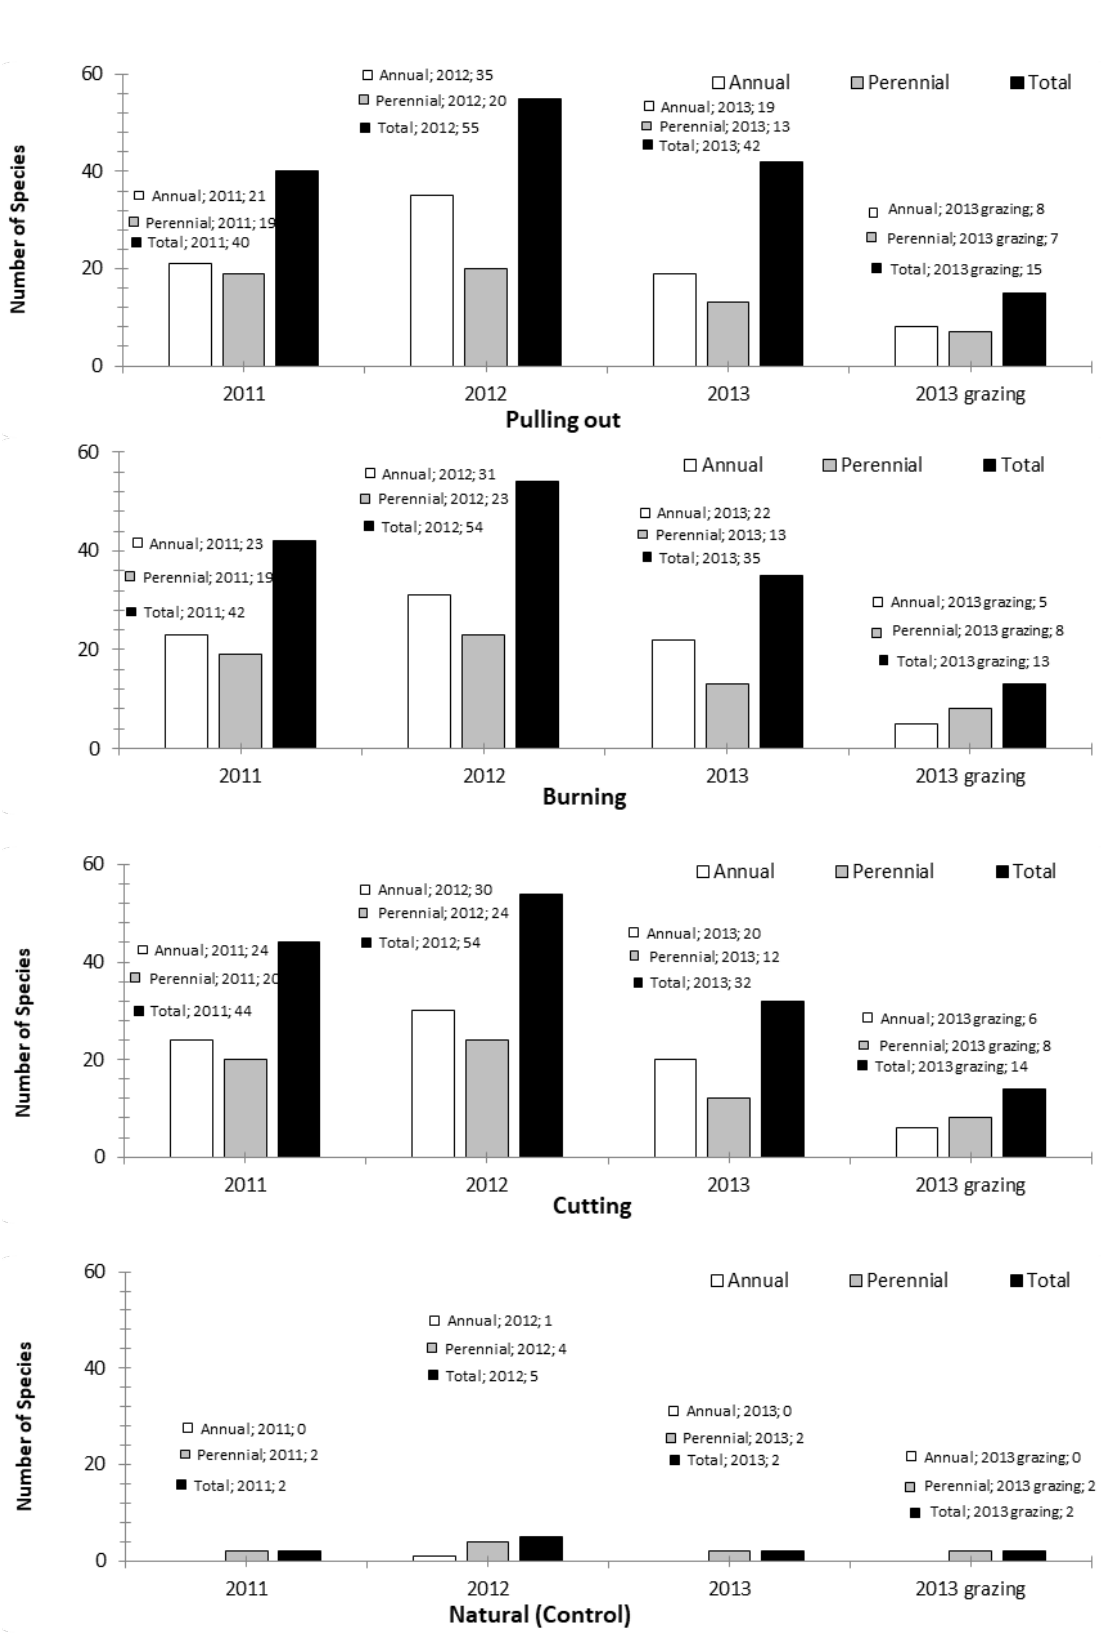
Figure 1. Number of annual/biennial and perennial species in vegetation cover according to de- velopment method. opment